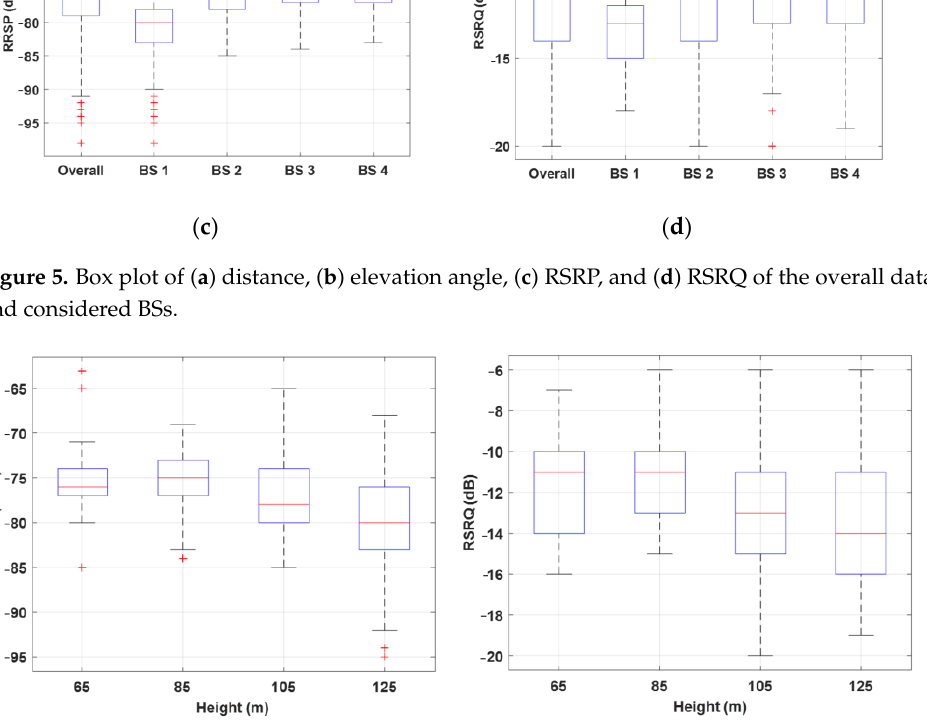
Table 7. The number of handovers in different routes and flight heights.